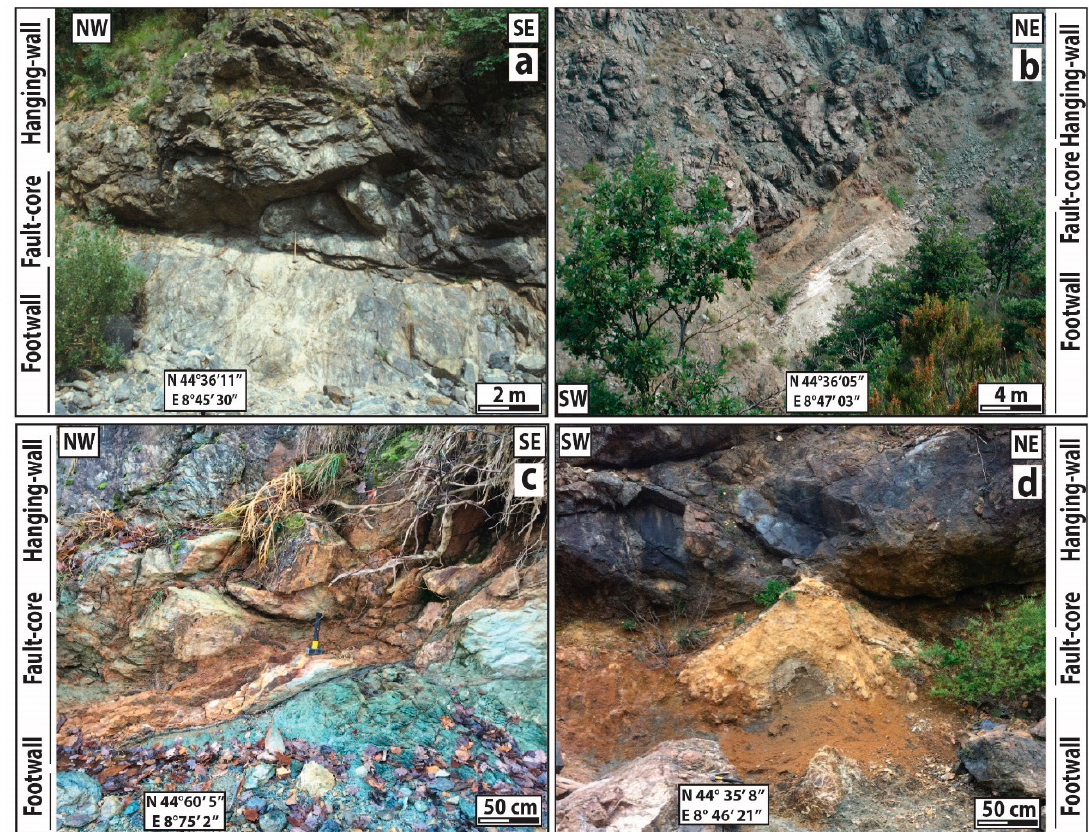
Figure 4. (Color online): Representative examples of well-exposed fault zones in the area: ( a ) fault developed within serpentinites; ( b ) fault developed at the lithological transition between lherzolites and serpentinites, characterized by intense carbonation along the fault core; and ( c,d ) fault developed within lherzolites, characterized by intense carbonation along the fault core.